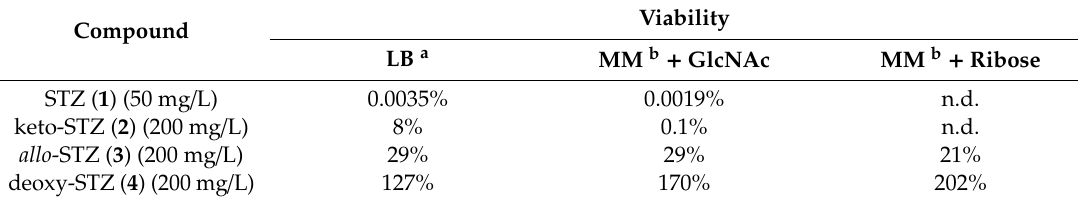
Table 2. Results from the growth-based viability assays using compounds 1 – 4 .